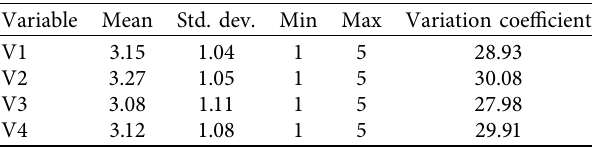
Table 2: Variation coefficient of learning environment